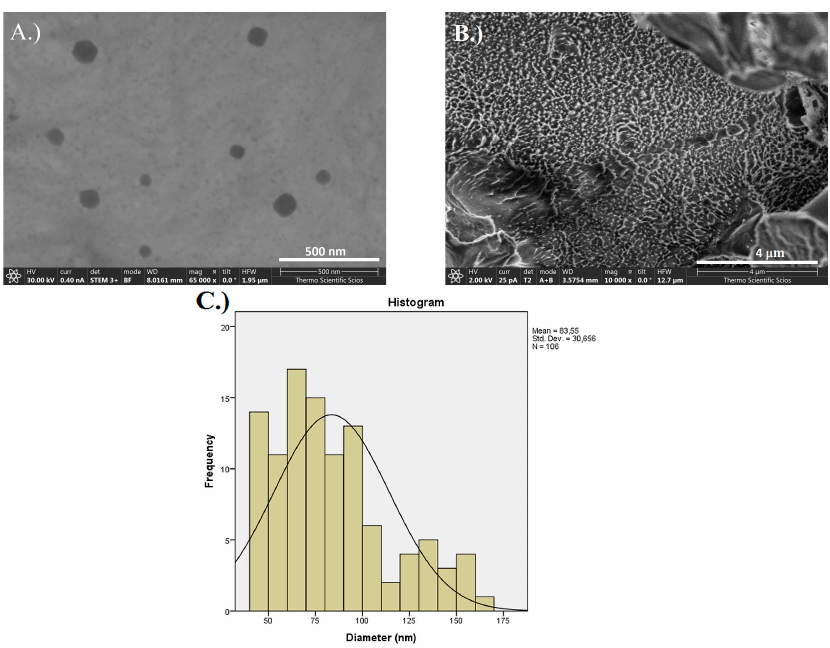
Figure 3. ( A ) STEM images of PGA-MNP polymer, ( B ) SEM image of broken NCHG sample surface, and ( C ) size distribution graph of the